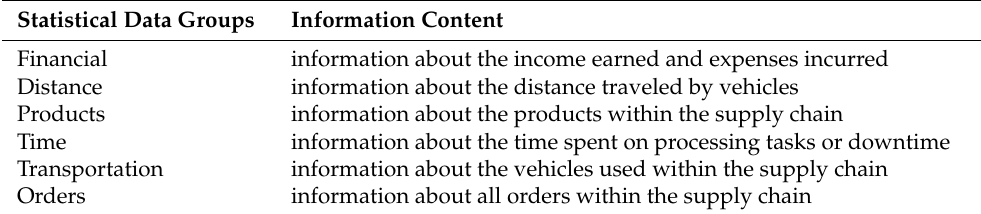
Table 2. Input statistical data of the supply chain risk analysis